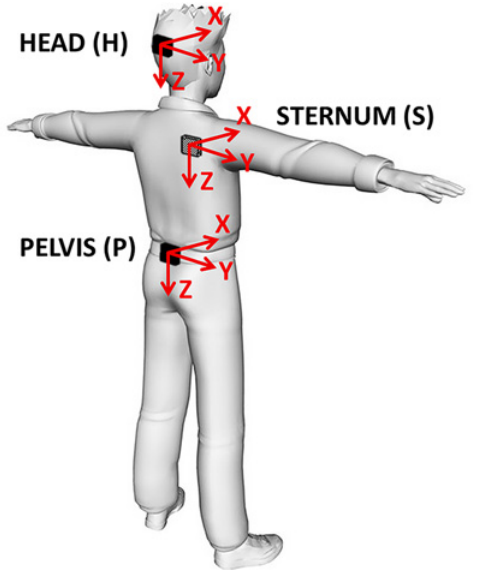
Fig 1. Sensor location and axes orientation of the Magneto-Inertial Measurement Units (MIMUs) attached on the children ’ s body segments. H: head level; S: sternum level; P: pelvis.